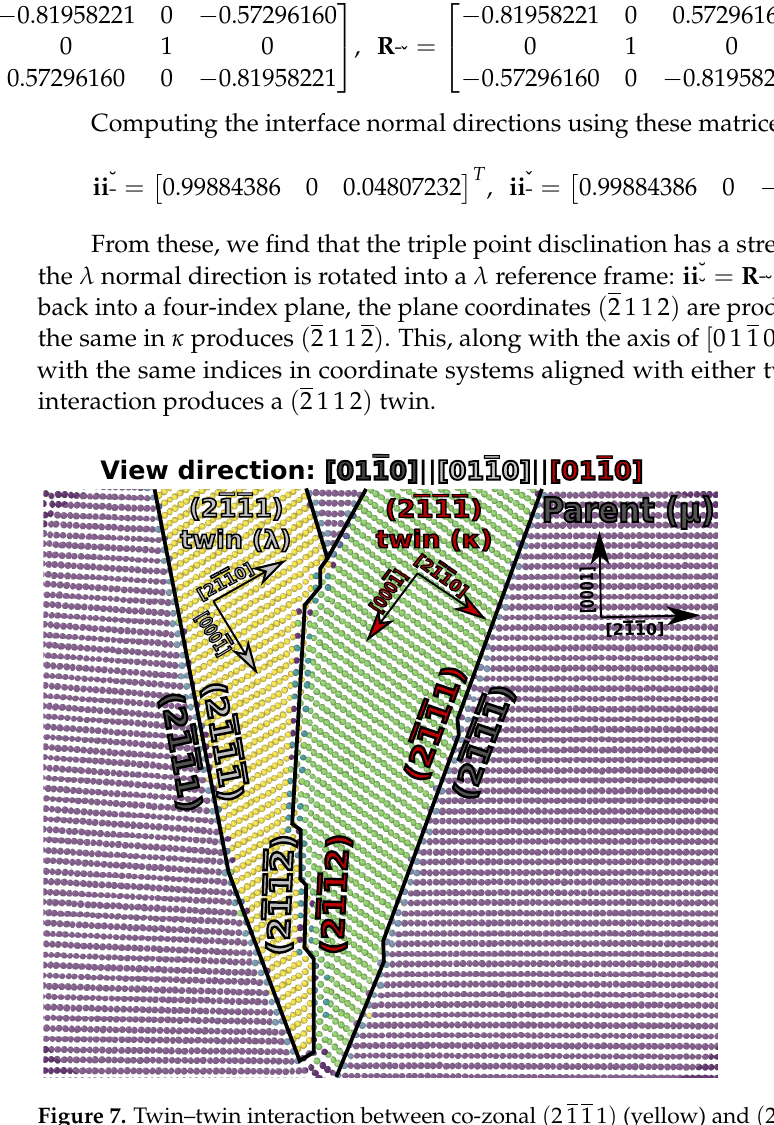
Figure 7. Twin–twin interaction between co-zonal ( 2111 ) (yellow) and ( 2111 ) (green) twins. The twin–twin interface was a ( 2112 ) twin boundary, which had limited mobility as visible in the figure. Steps could nucleate and move in the new boundary; however, the triple points cannot conservatively move left or